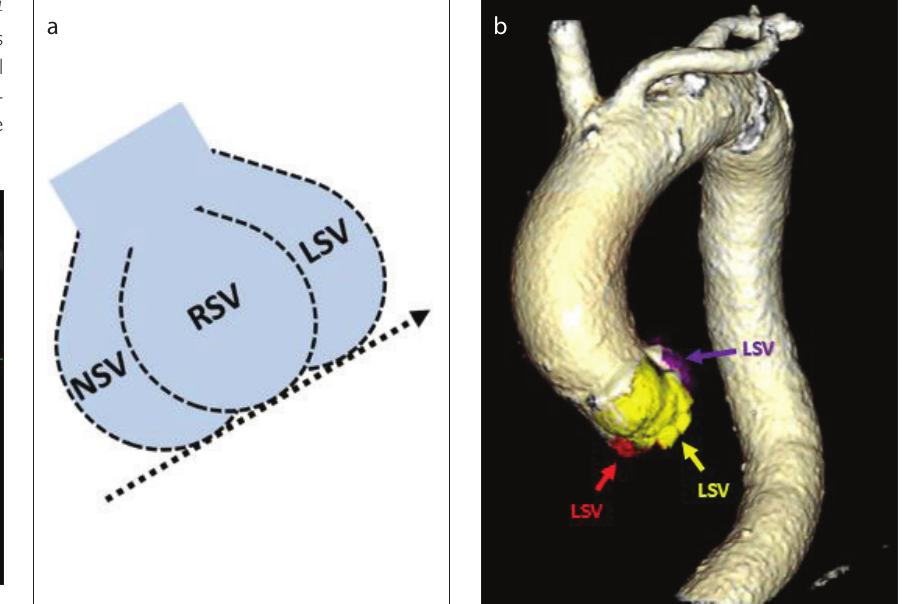
Figure 6. Multidetector computed tomography Figure 8. a, b. a) Diagram of the appearance of the aortic root when viewed by the interventionalist angiography measurement of the sinus of in the optimal plane, with the right sinus of Valsalva (RSV) in the center. b) Three-dimensional volume- Valsalva diameter from the left, right, and noncoronary cusps (LCC, RCC, and NCC, respectively).